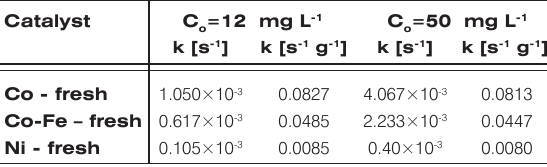
Table 4. Degree of MB mineralization over studied catalysts Catalyst